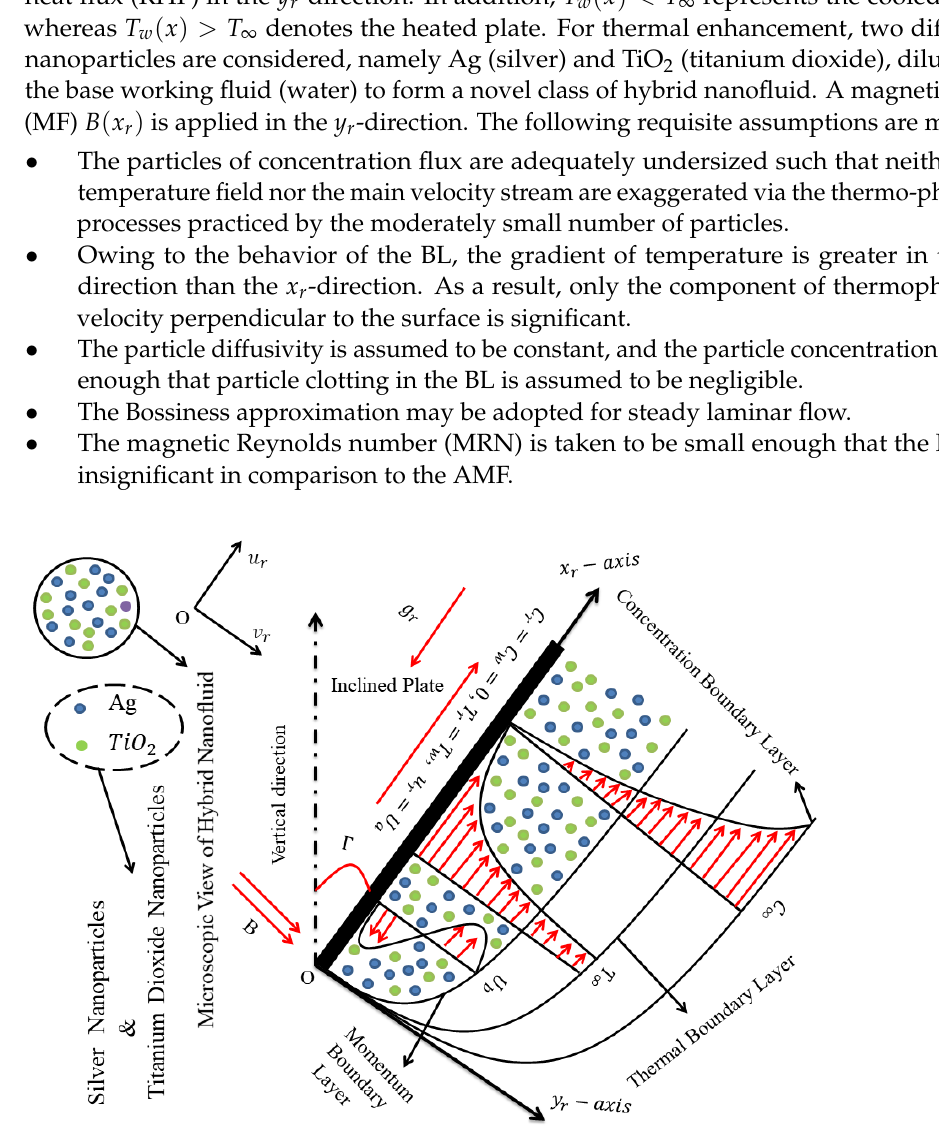
Figure 1. Physical model and Cartesian coordinates.